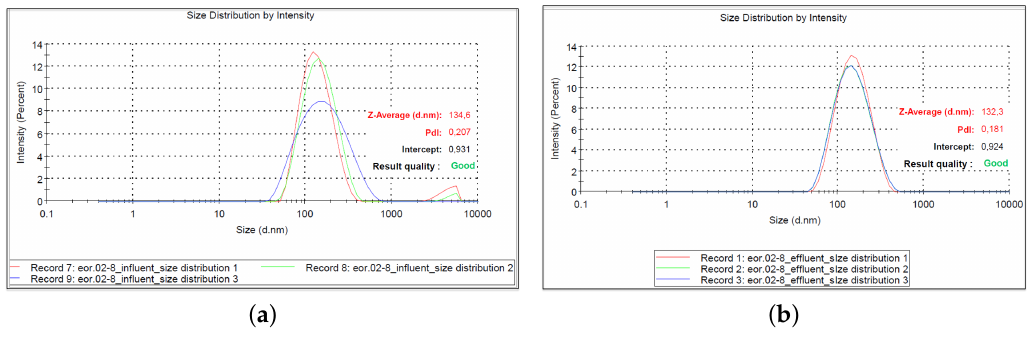
Figure A6. Nanoparticle size distribution for sample NF4 at 0.1 wt %: ( a ) influent; and ( b )